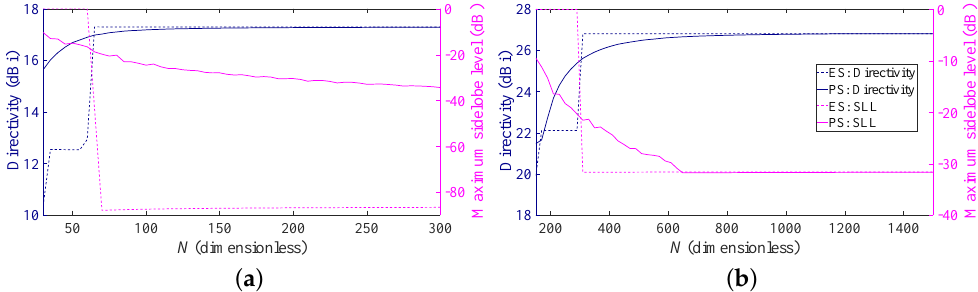
Figure 6. Obtained directivity and SLL as a function of the number of elements. Solid lines refer to PS, and dashed lines refer to ES: ( a ) desired BW = 1 ◦ , b = 3, L / λ = 60, ( b ) desired BW = 0.1 ◦ , b = 3, L / λ = 300.